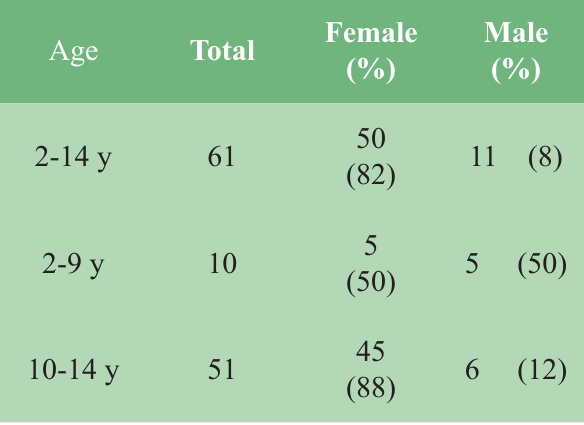
Table 2. Yearly distribution of cholecystectomy